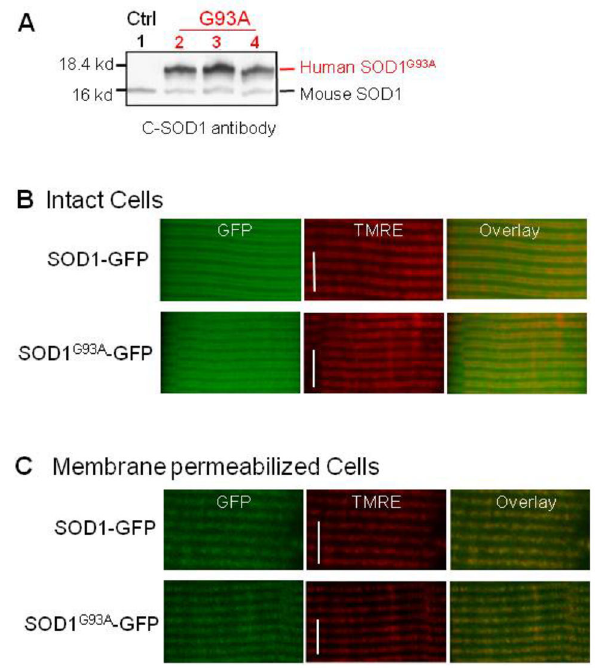
Figure 3. Cytosolic SOD1 proteins can be transported into mitochondria of skeletal muscle. ( A ) Western blot to show the expression of human SOD1 G93A in the skeletal muscle of G93A mice. C-SOD1 antibody recognizes both mouse and human SOD1. Lane 1: Control muscle; Lane 2-4: G93A muscle (2,3 and 4-month old). Note the skeletal muscle of G93A mice expresses human SOD1 G93A at all ages. ( B ) Intact normal muscle fibers expressing SOD1-GFP or SOD1 G93A -GFP.